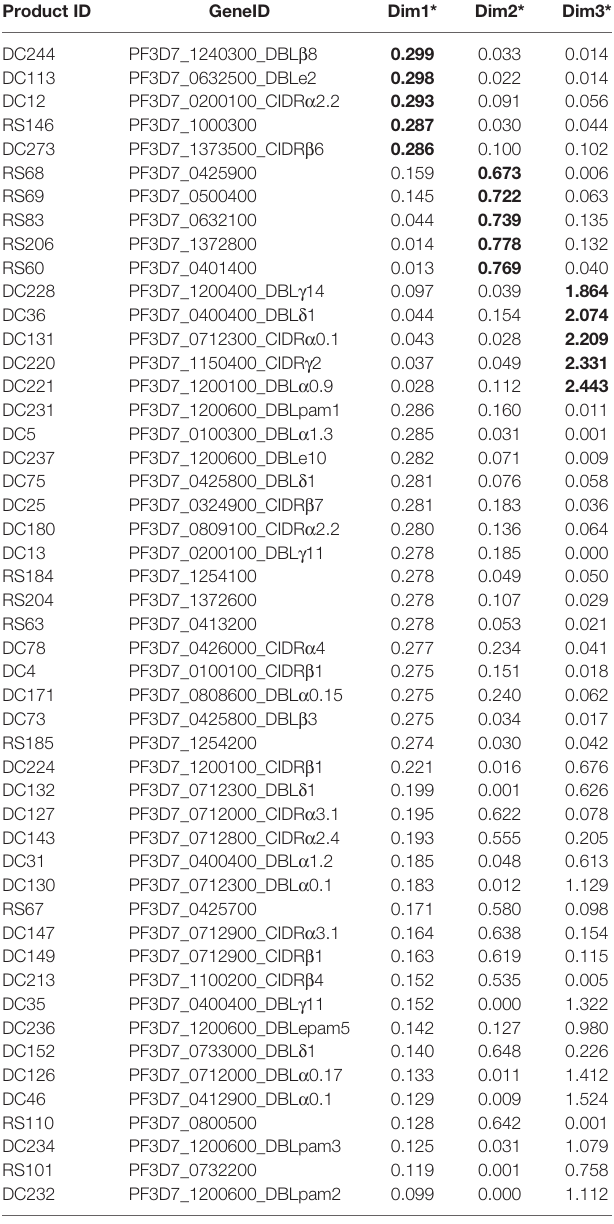
TABLE 2 | Top 50 antigens based on respective contributions to variability in principal components 1, 2 and 3 (Dim1, Dim2, Dim3). Product